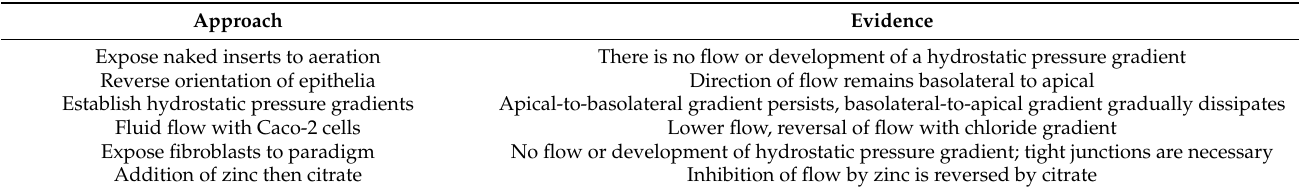
Table 3. Experimental evidence from inserts and cultured small intestinal epithelia that demonstrates unidirectional apically directed fluid flow is not an artifact of